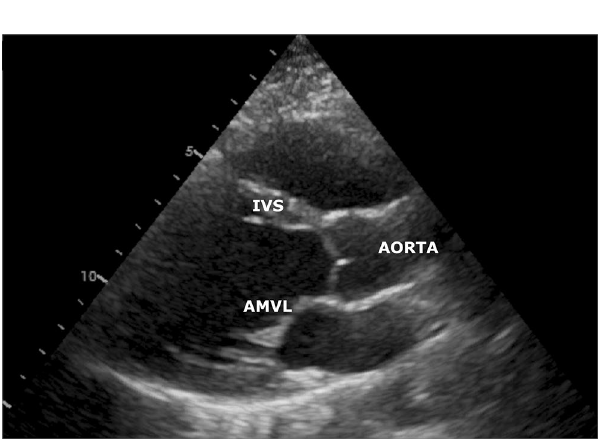
Figure 1. B-mode image of the heart in the PLAX view. Additionally marked structures are: the beginning of the aorta, the anterior mitral valve leaflet (AMVL), and the interventricular septum